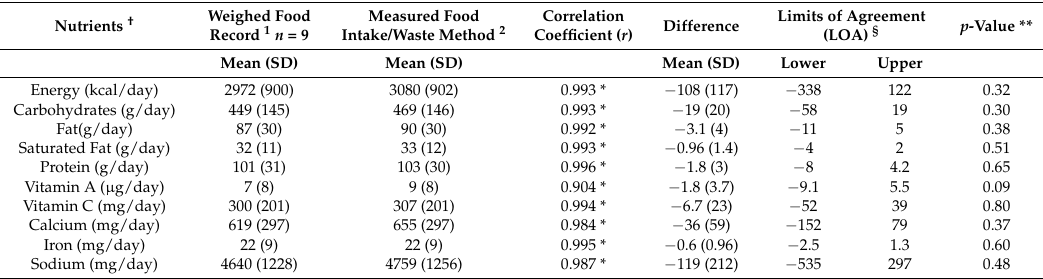
Table 3. Daily energy and nutrient intakes recorded by CAF personnel using the weighed food record (wFR) 1 and those obtained from the measured food intake/food waste method 2 (reference method) (Means ± Standard Deviations (SD)).